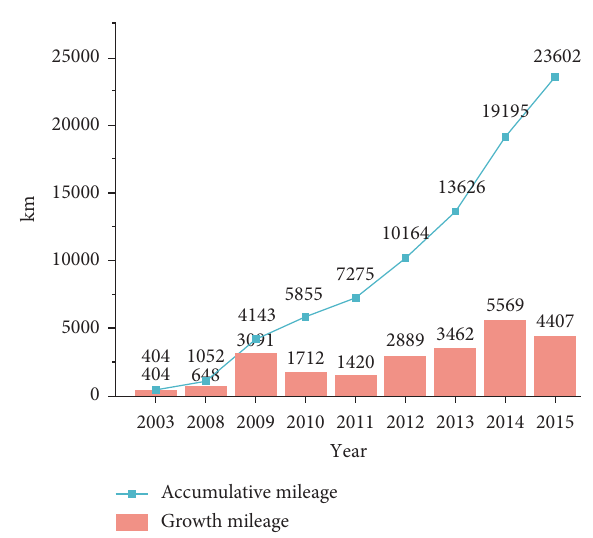
Figure 2: China HSR growth and accumulative